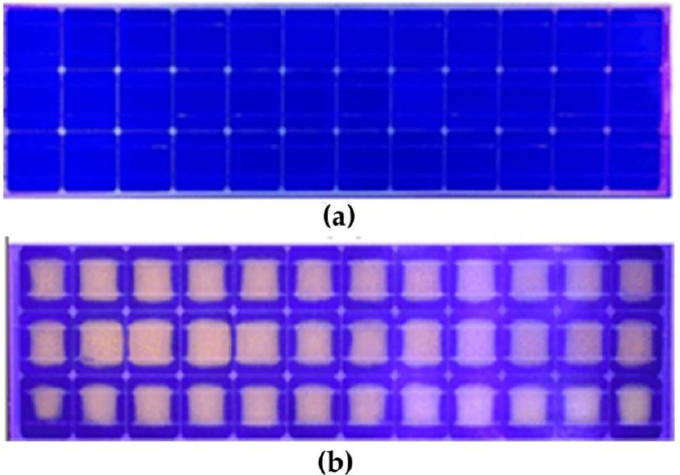
Figure 7. Typical UV fluorescence images of a PV module ( a ) unexposed using CMOS camera, ( b ) Figure 7. TypicalUVfluorescenceimagesofaPVmodule( a )unexposedusingCMOScamera,( b )Grayscaled Grayscaled image using CCD camera [40]. image using CCD camera